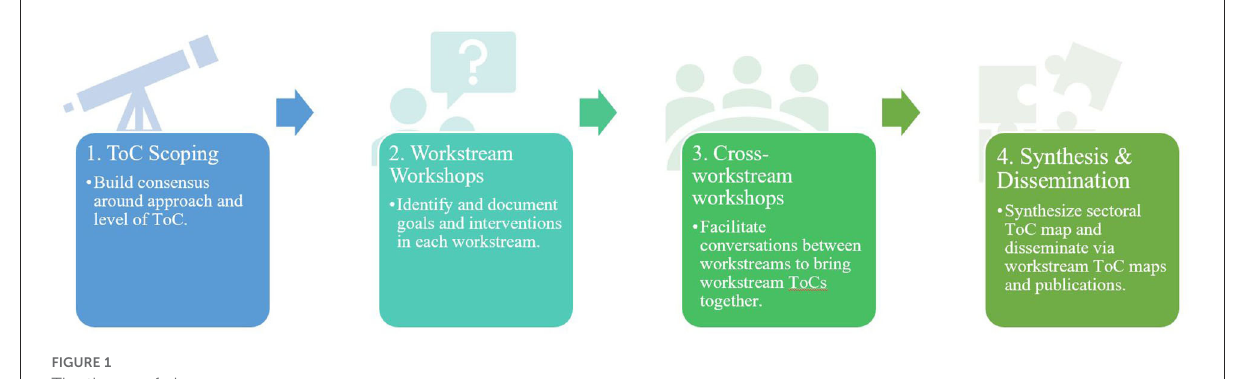
FIGURE1 The theory of change